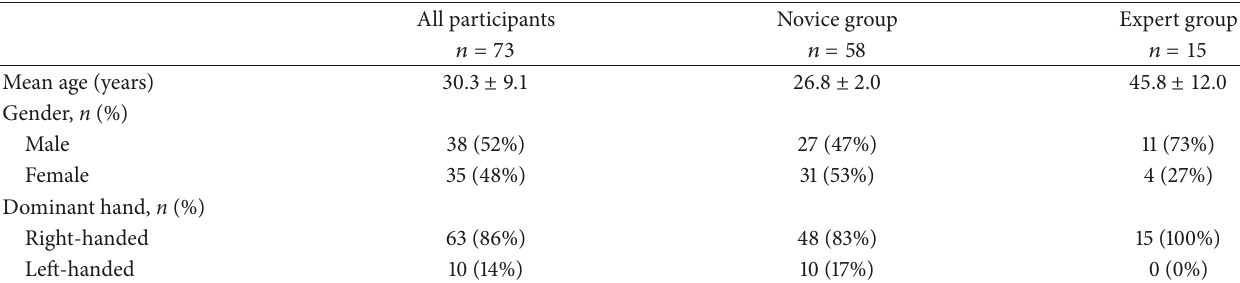
Table 1: Demographic characteristics of